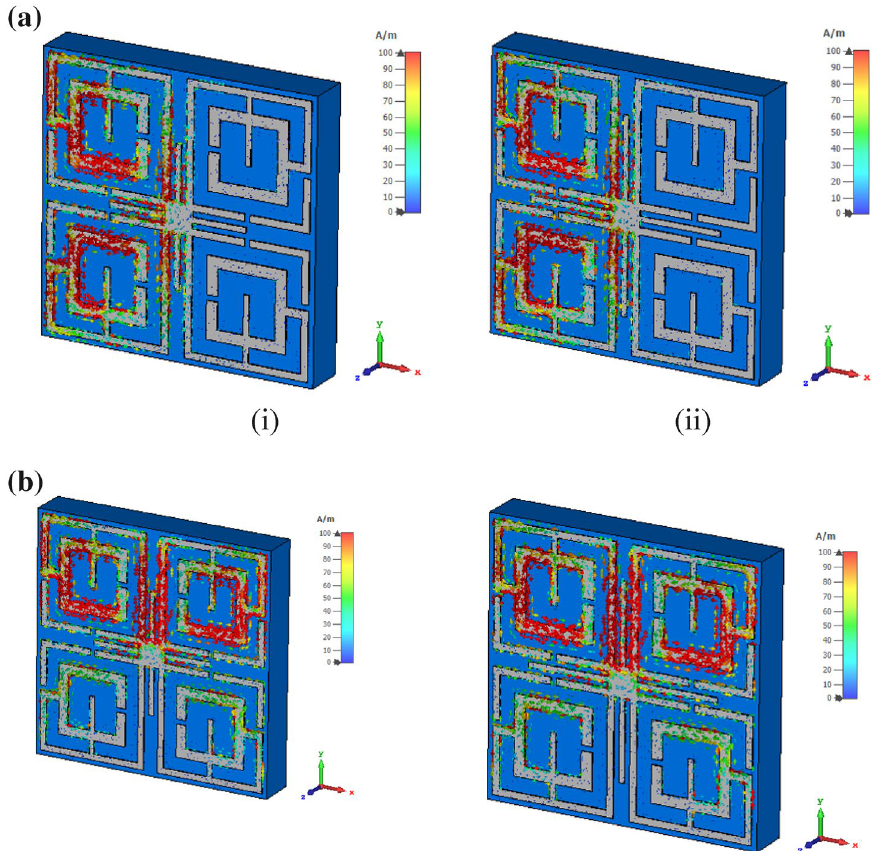
Figure 9. ( a ) Surface current distribution at 11.5 GHz for the wave guide port oriented in X direction. (i) for l = 2.5 mm, (ii) for l = 3.5 mm. ( b ) Surface current distribution at 11.5 GHz for the wave guide port oriented in Y direction. (i) for l = 2.5 mm, (ii) for l = 3.5 mm (CST STUDIO SUITE 2019, https:// www. 3ds. com/ produ cts- servi ces/ simul ia/ produ cts/ cst- studio- suite) 42